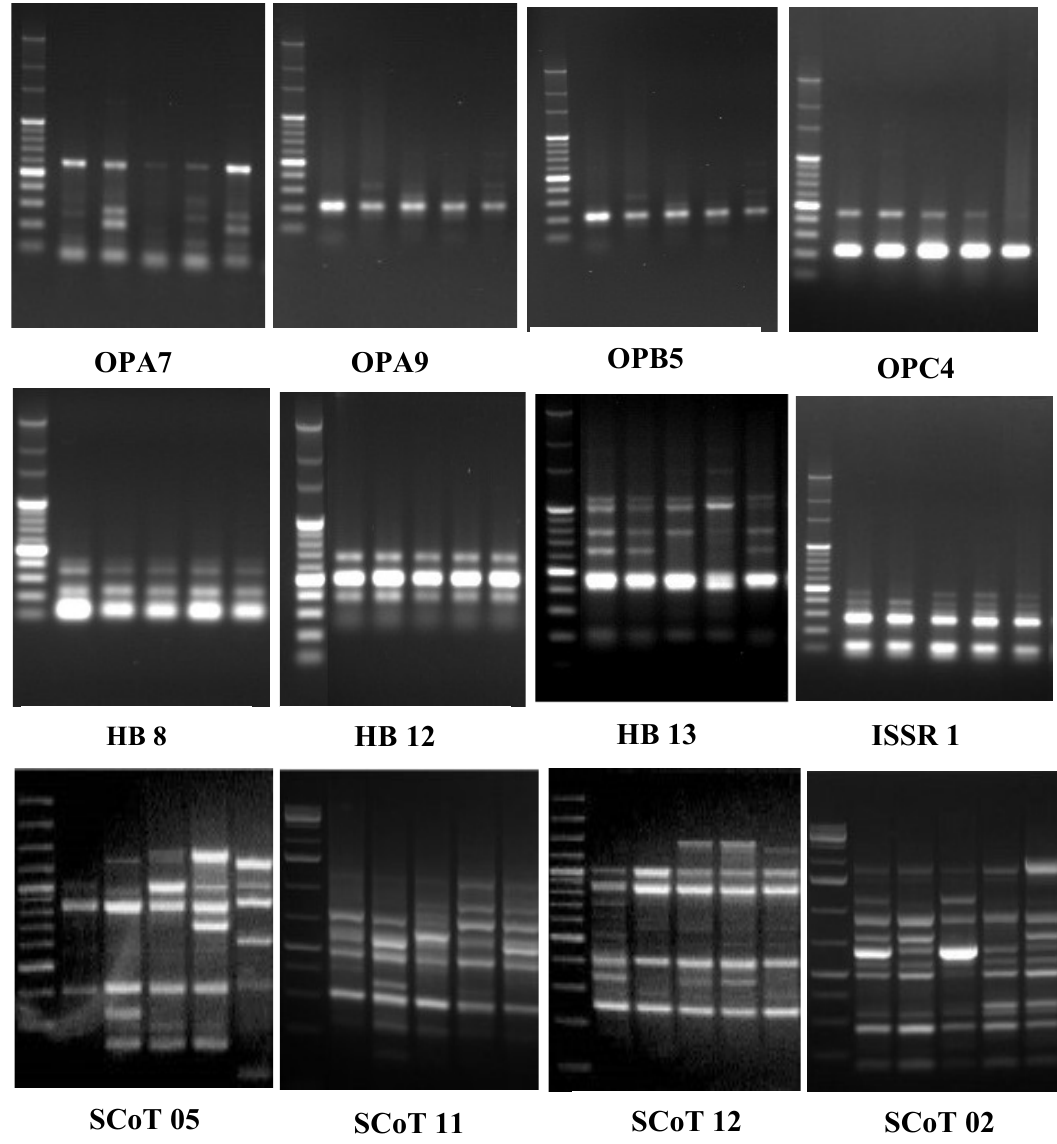
Figure 7. Band profiles of SCoT, ISSR, and RAPD markers. Lane 1: DNA ladder (100 bp), Lanes 2 to 6: Taxa 1 to 5 (From left to right).